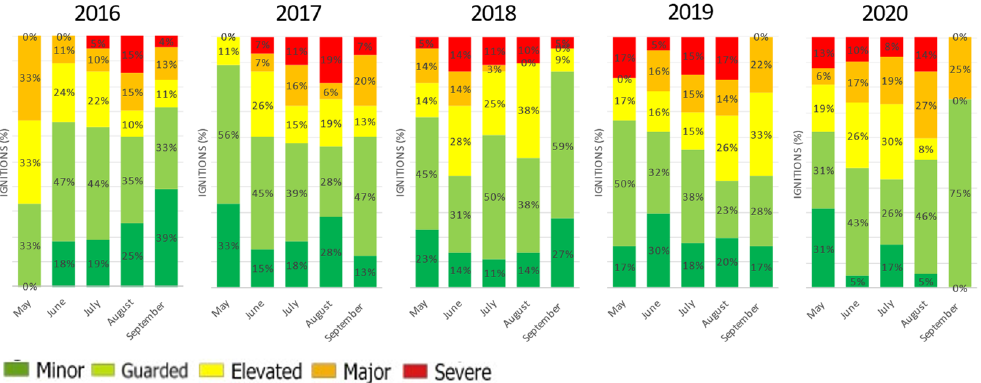
Figure 6. The monthly ignitions since the last MDIR model for the five risk classes during each year of the five-year study.